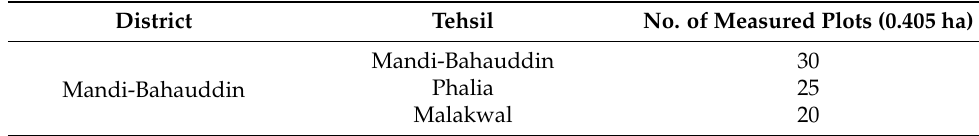
Table 1. Number of plots measured from selected Tehsils in Mandi-Bahauddin sampling. District Tehsil No. of Measured Plots (0.405 ha)